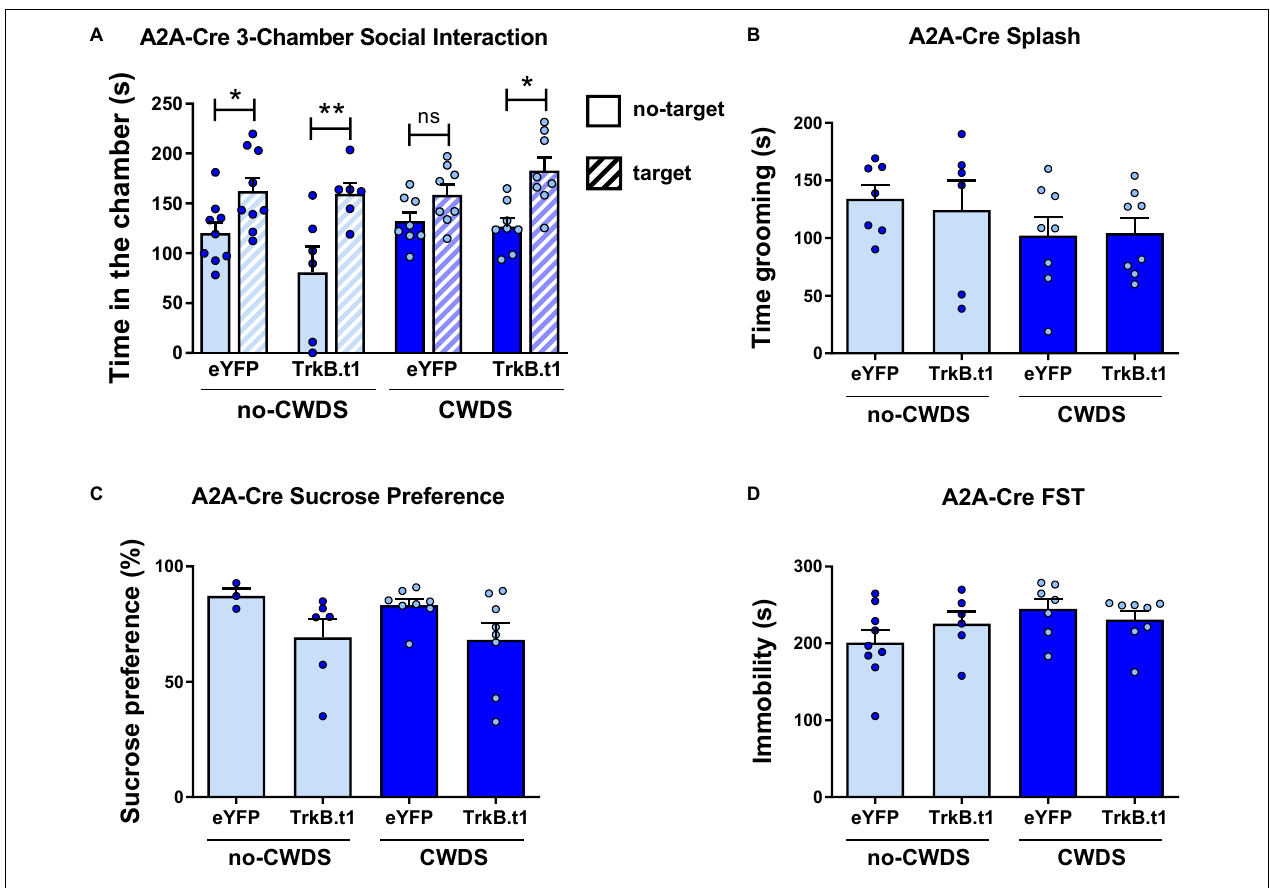
FIGURE 4 | Blocking BDNF-TrkB signaling in D2-MSNs induces a resilient phenotype after 10 days of chronic witness defeat stress (CWDS) in female mice. (A) CWDS-eYFP group did not show preference for the novel social target during the 3-chamber social test, a behavior prevented by TrkB.t1 expression in D2-MSNs ( N = 6–9). (B–D) Total time in grooming during the sucrose splash test ( N = 6–8), the sucrose preference test ( N = 3–8), or the forced swim test ( N = 6–9) was not significant across groups (* p ≤ 0.05; ** p ≤ 0.01).